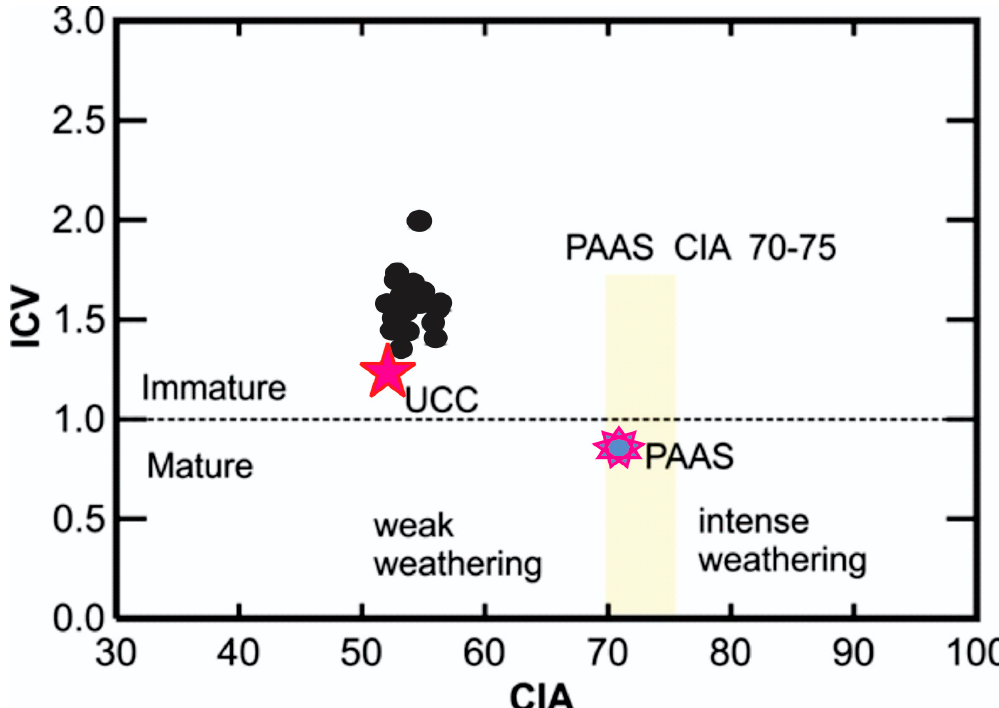
Figure 16. ICV (Index of Compositional Variability) versus CIA (Chemical Index of Alteration) plot for the Brahmaputra River sediments (after Long et al. [66]). Brahmaputra River sediment samples are represented by the black dots. UCC (Upper Continental Crust) and PAAS (Post ‐ Archean Australian Shale) values after Taylor and McLennan [30] are included for comparison.